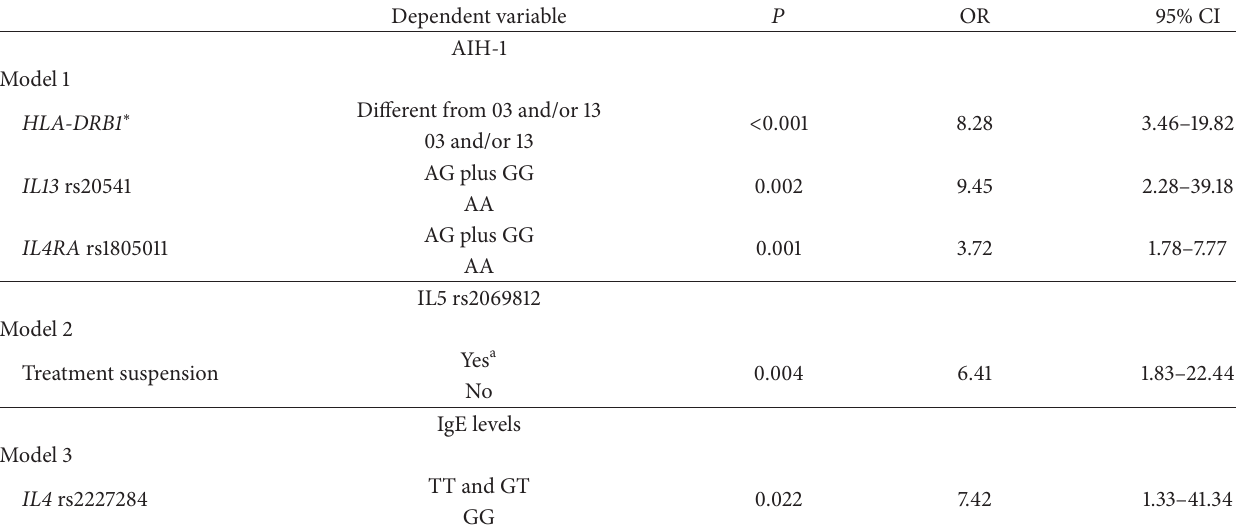
Table 5: Multivariate analysis of factors associated with AIH-1, using three different